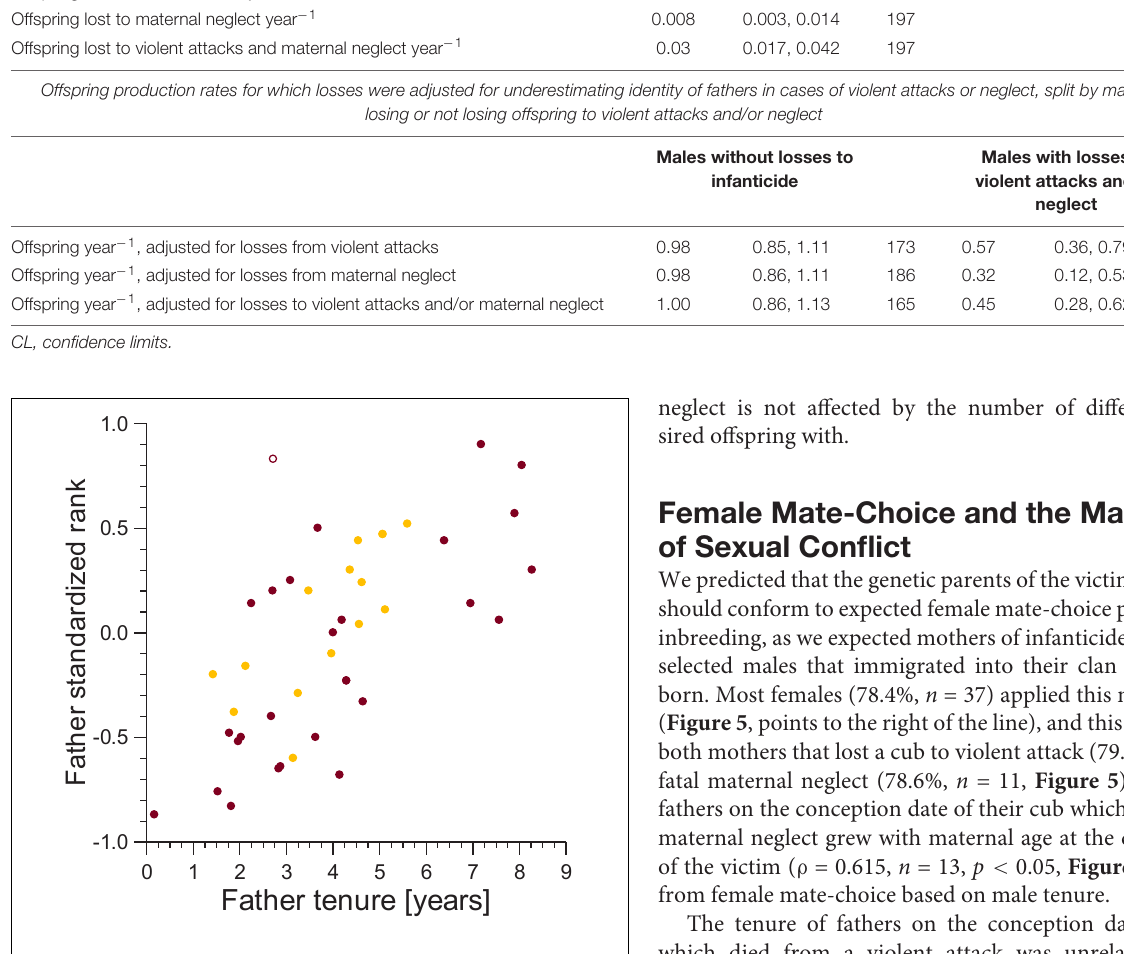
FIGURE 4 | Male standardized rank in relation to breeding tenure for males that lost cubs to violent attacks (burgundy) and maternal neglect (amber) on the day of the conception of the victim. Filled symbol: immigrant males, open symbol: natal male.